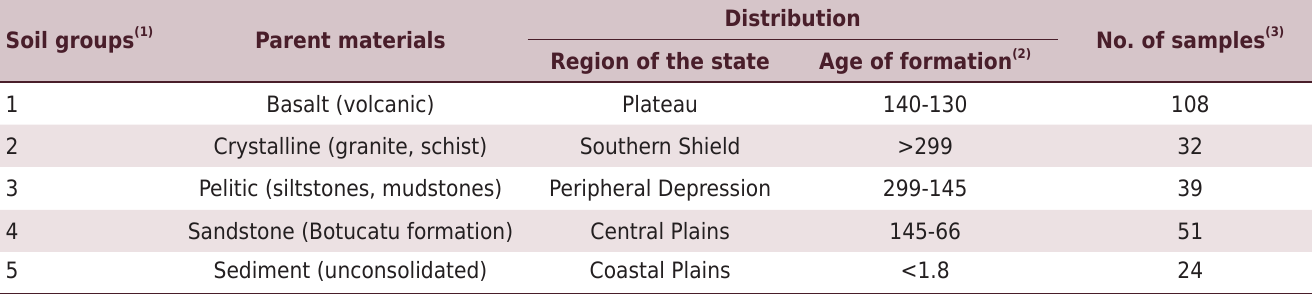
Table 1. Soil groups with their parent materials, distribution in the state of Rio Grande do Sul (Brazil), and the number of samples used in this study Soil groups